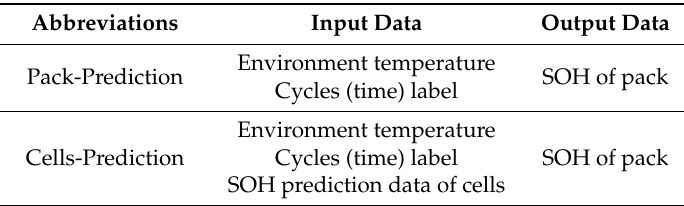
Table 3. Abbreviations of the SOH prediction methods.